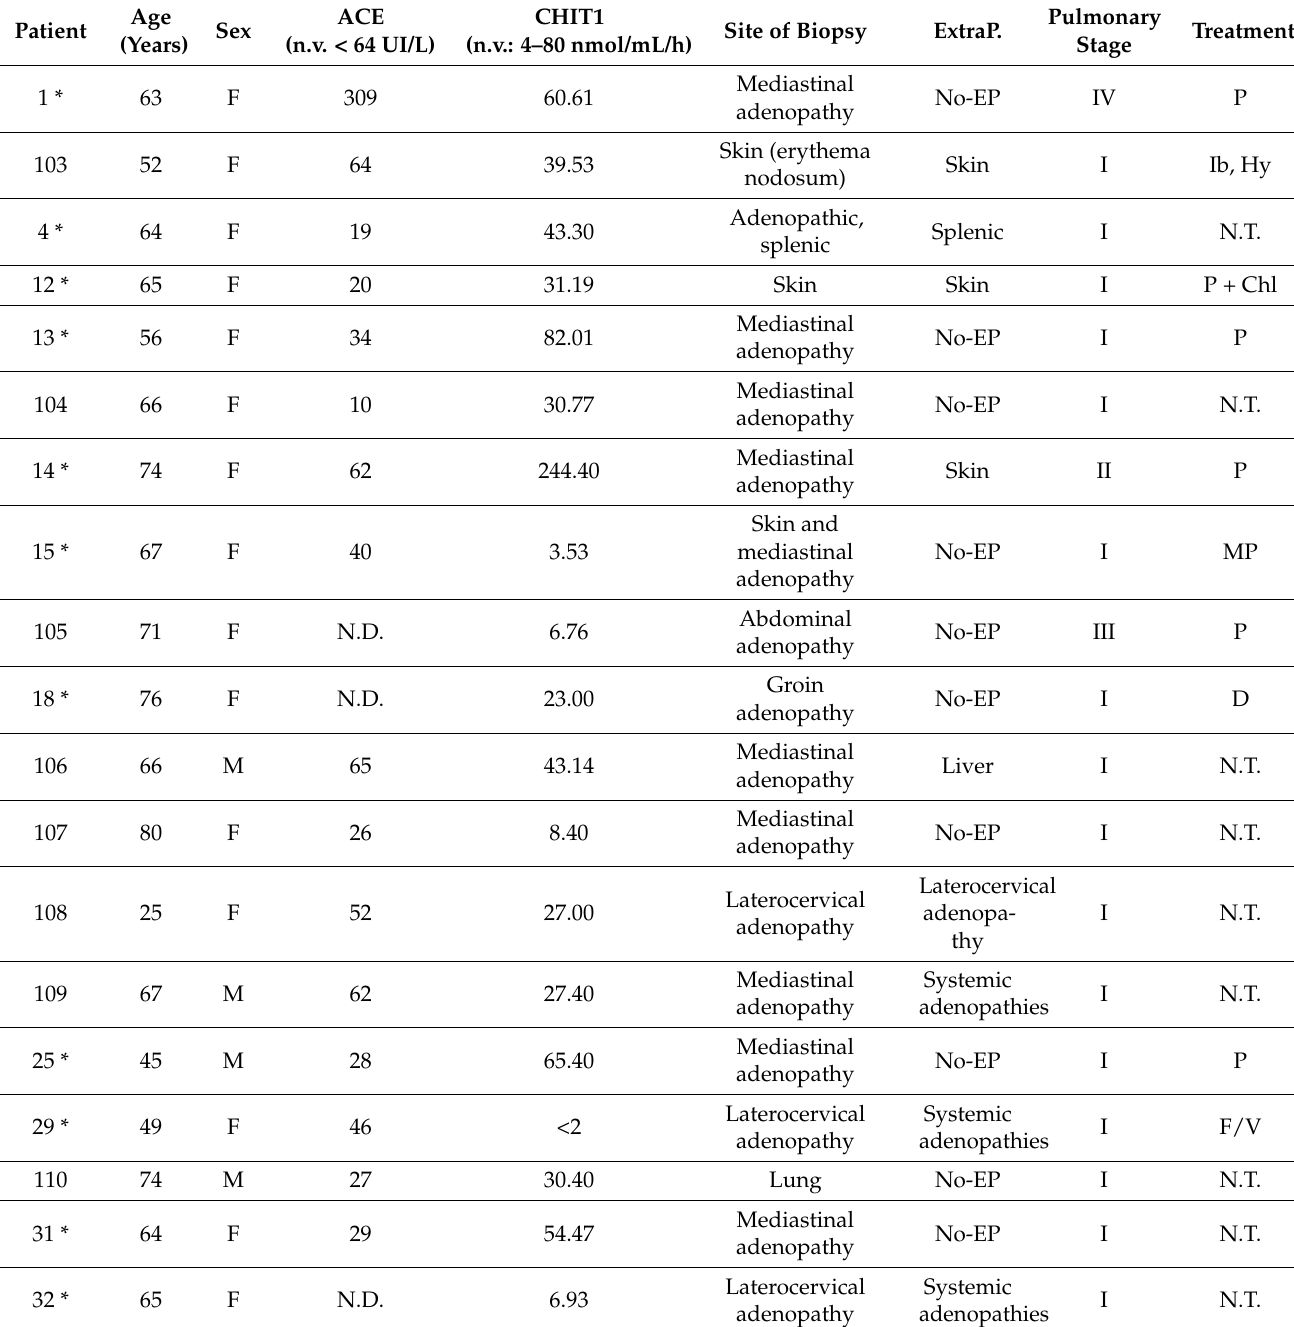
Table 3. Study Group 3 (inactive/after treatment sarcoidosis).